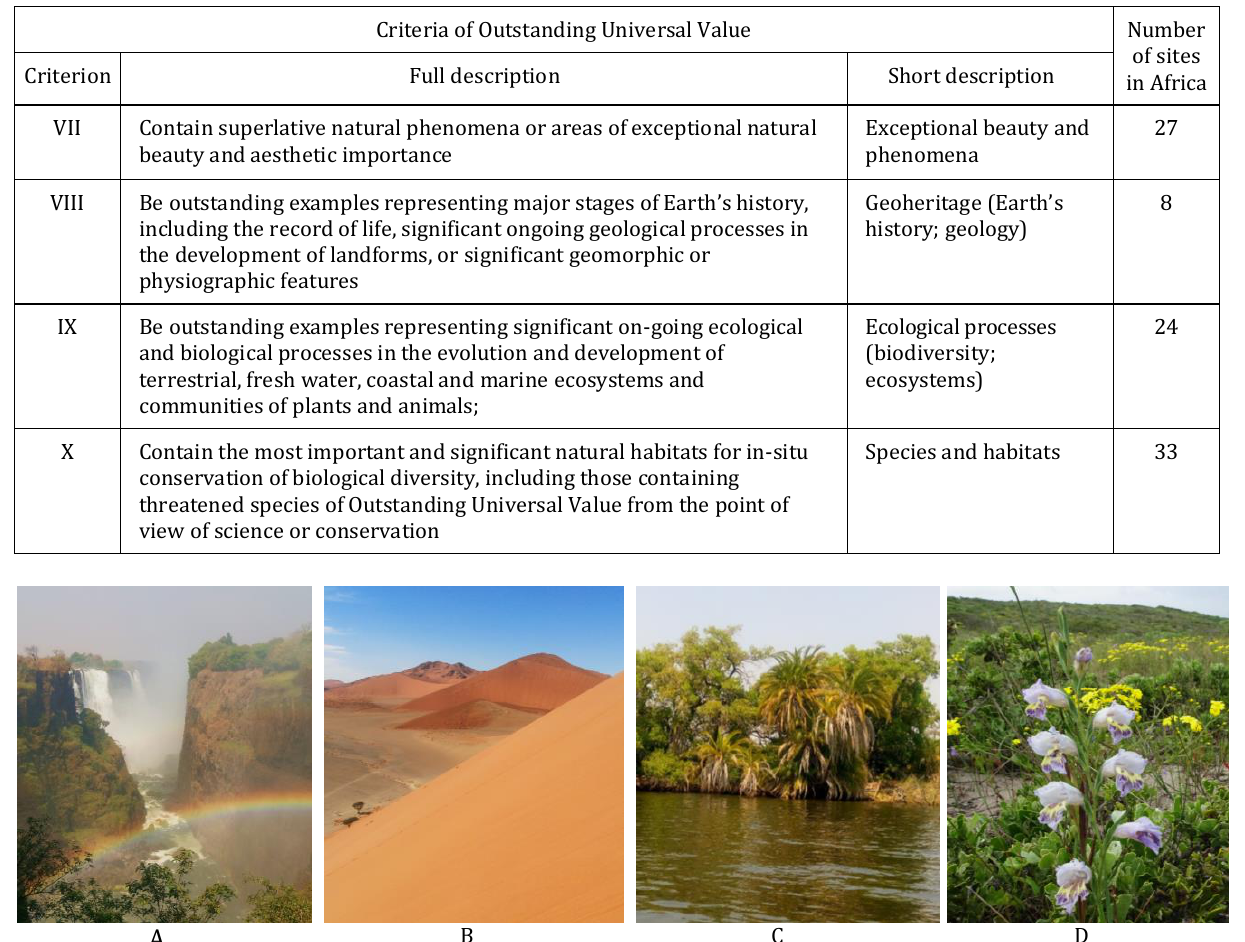
Table 3. Natural and mixed World Heritage sites in Africa according to criteria of Outstanding Universal Value Criteria of Outstanding Universal Value